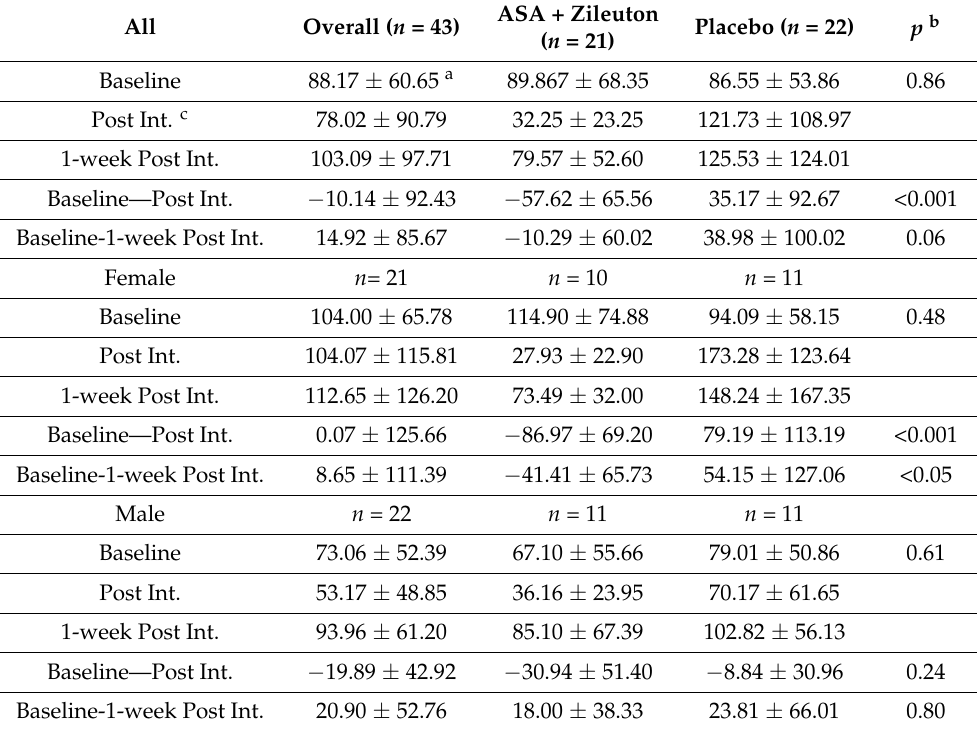
Table 6. Summary of the change in LTE4 levels by treatment group and by gender.